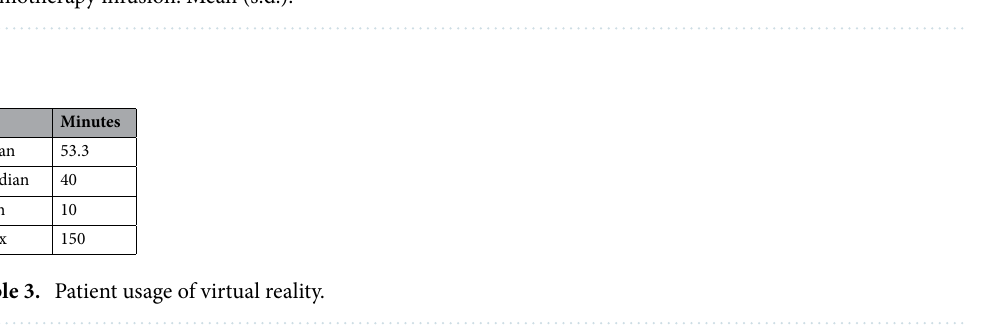
Table 2. Biological Results in the Control, Green Therapy and Virtual Reality rooms before and after chemotherapy infusion: Mean (s.d.).